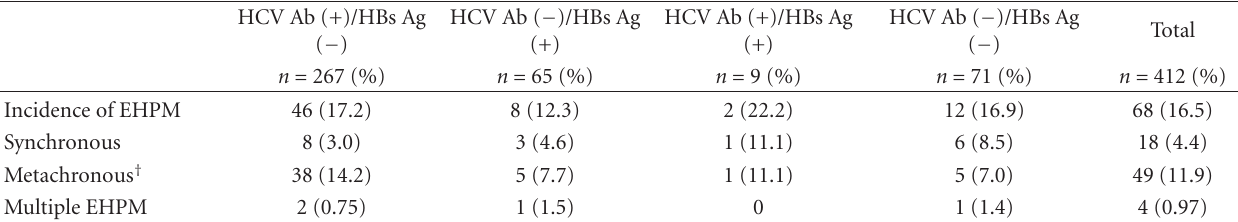
Table 2: Synchronous, metachronous, and multiple EHPM and viral infection status.